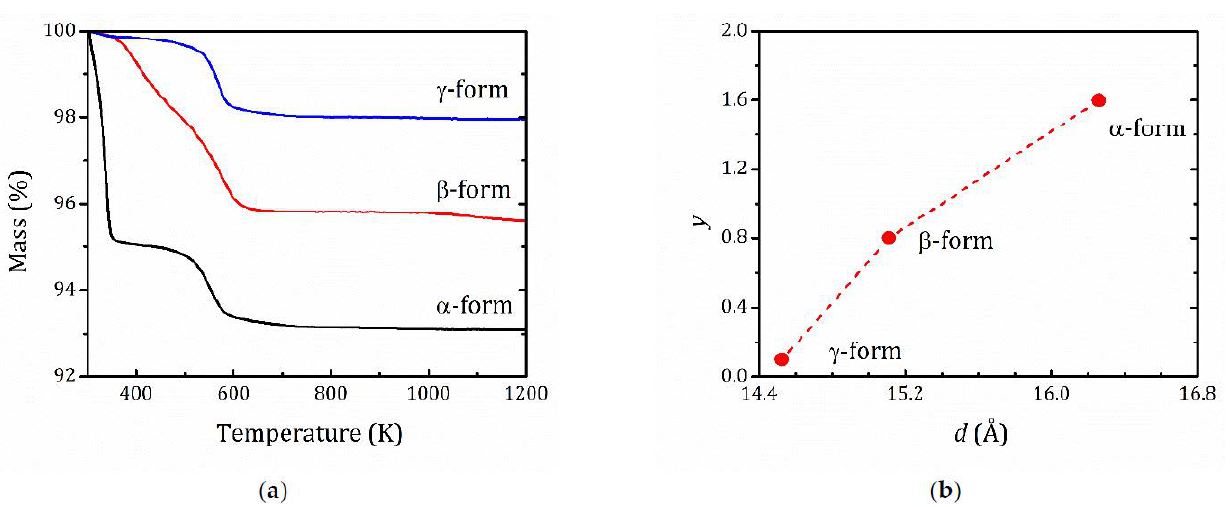
Figure 2. ( a ) TG curves for the studied forms of HCa 2 Nb 3 O 10 · y H 2 O with different hydration levels; ( b ) number of H 2 O molecules per formula units ( y ) versus the interlayer space ( d